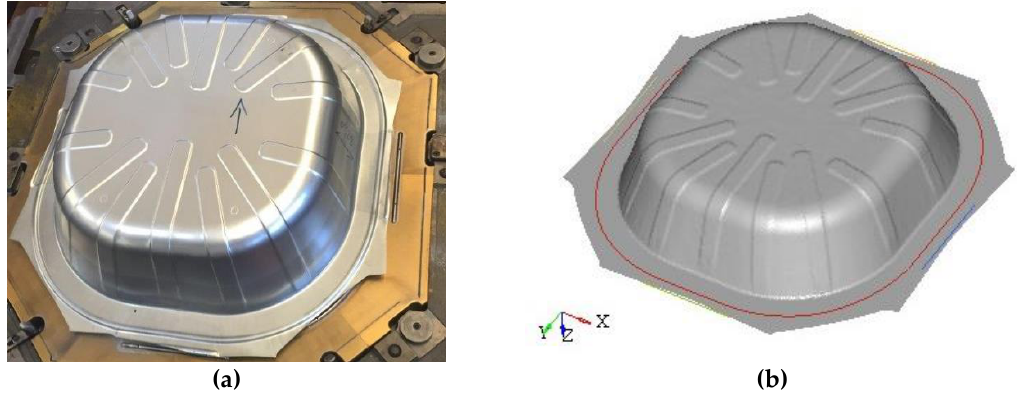
Figure 5. Comparison between: ( a ) the real product obtained by forming using a traditional mechanical press and ( b ) the numerical model.